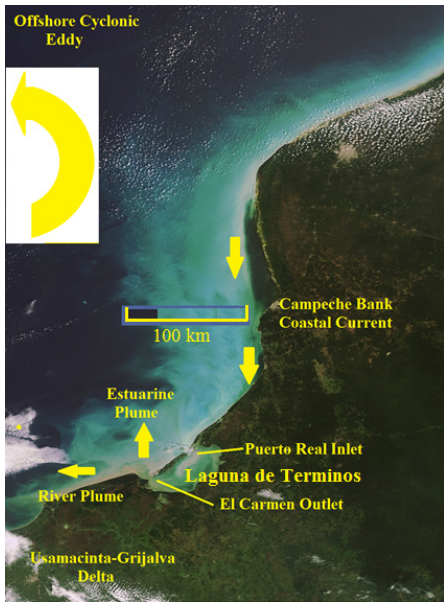
Figure 4. Laguna de Terminos estuary showing river and estuarine plumes in the southeastern Bay of Campeche in a Landsat image acquired on 26 January 2010.